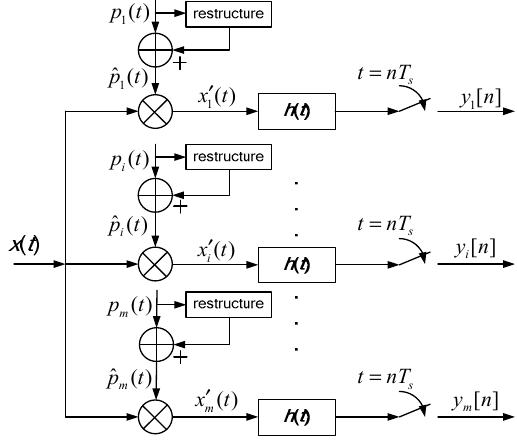
Figure 4. Channelized MWC under-sampling system.